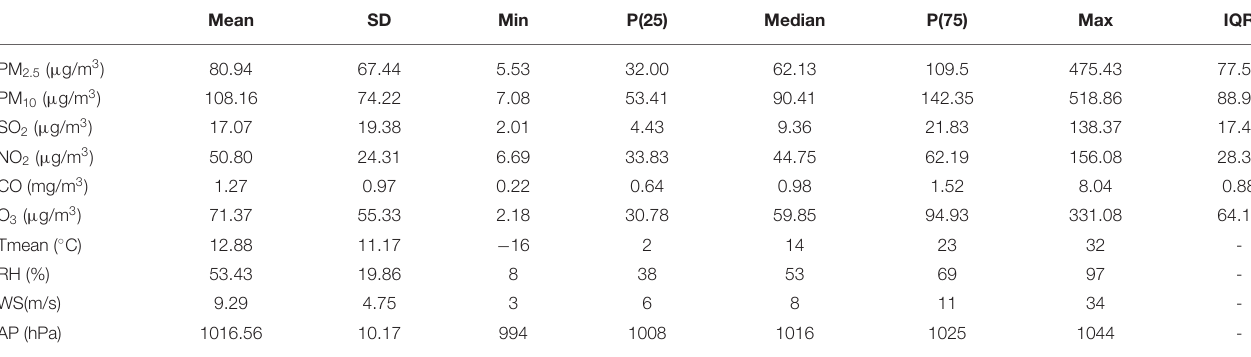
SD, standard deviation; Min, minimum; Max, maximum; P(25), 25th percentile; P(75), 75th percentile; IQR, interquartile range; Tmean, daily mean temperature; RH, relative humidity; WS, wind speed; AP, air pressure.